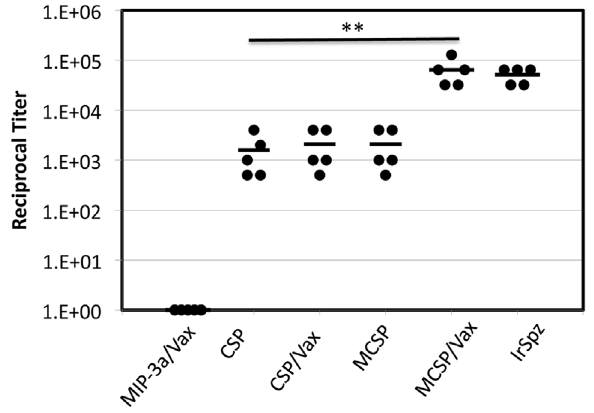
Figure 3. Antibody titers in C57Bl/6 mice immunized with P. yoelii CSP DNA constructs Specific antibody concentrations in sera obtained two weeks after the final immunization. Values shown represent the reciprocal of the endpoint ELISA titer for each mouse (closed circles) and the mean of the reciprocal titers from the 5 mice in each group (horizontal broken lines). The endpoint titer is reported as the highest dilution of serum at which the absorbance was twice the value obtained using pre-immunization serum. The responses to irradiated sporozoite and MIP3 a -CSP/Vaxfectin immunization regi- mens did not differ (p . 0.9) and were significantly greater than those to the other immunization regimens (p , 0.001), as indicated by ** in the